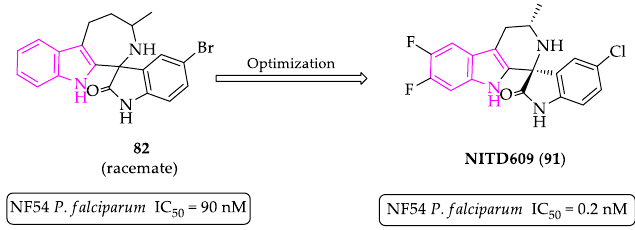
Figure 10. Optimization of compound 82 .